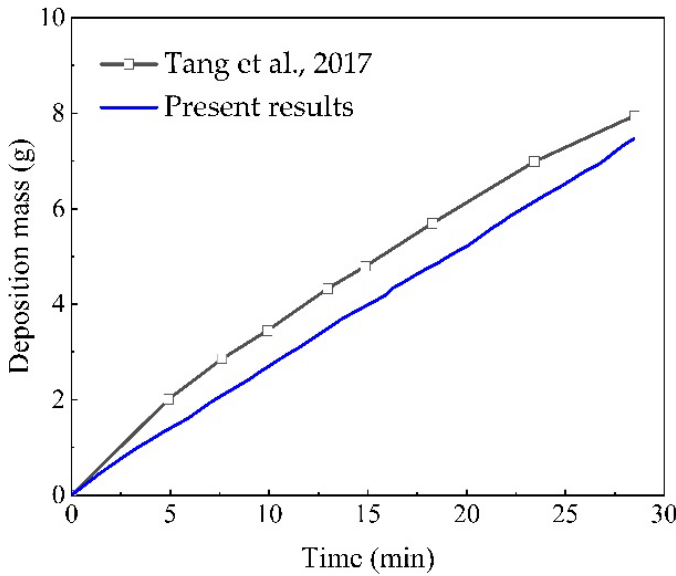
Figure 9. Comparing of experimental and numerical results of the fouling mass at various time [4].